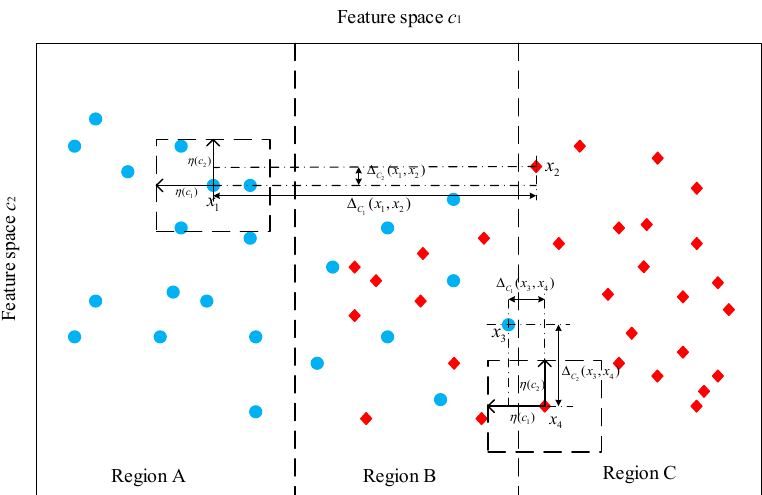
Figure 4. An illustration of discernibility matrix.